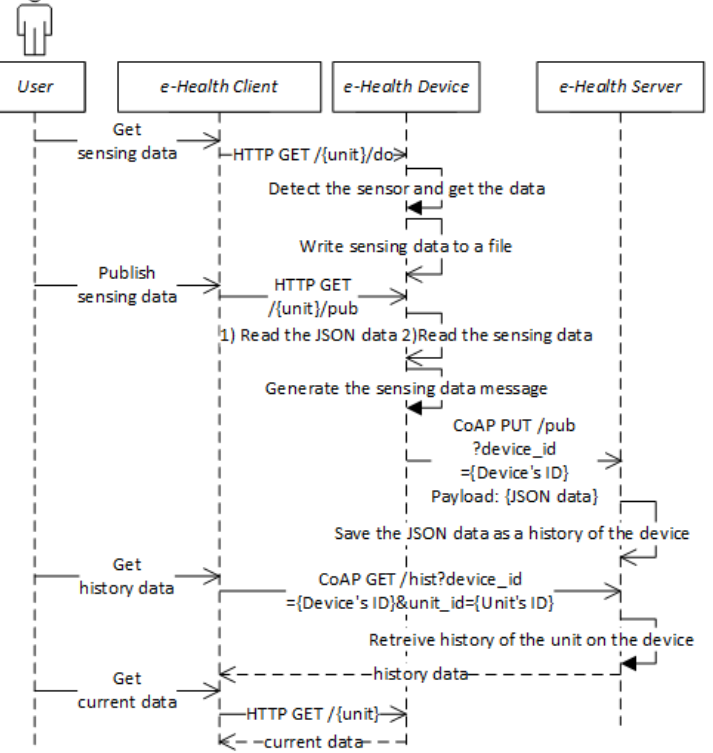
Figure 6. Sequence diagram of the healthcare system for Get sensing data, Publish sensing data, Get history data, and Get current